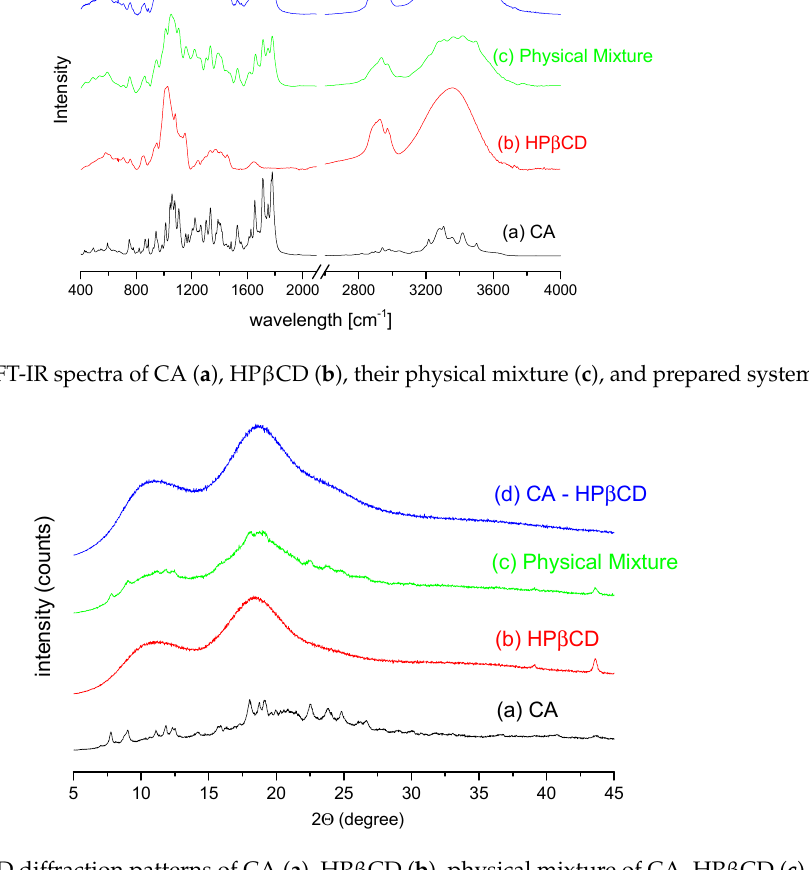
Figure 8. The apparent solubility profile of CA ( a ) and CA–HP β CD system ( b ).